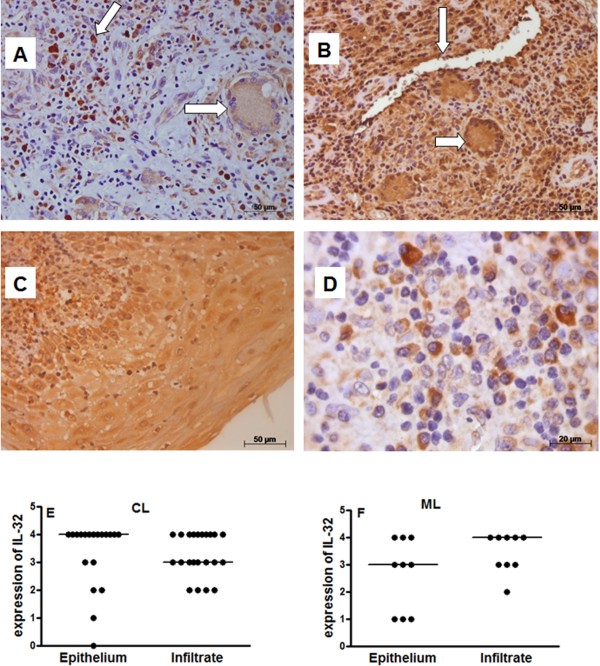
Expression of IL-32 is detected in different cells. Fragments of cutaneous or mucosal lesions were included in paraffin and sections were submitted to IHC for IL-32. The arrows show positive cells: In panel A: mononuclear cell and giant cell; and Panel B: endothelial cells and giant cell. In Panel C: positive keratinocytes; and Panel D: several positive mononuclear cells. The expression of IL-32 was determined, under light microscopy, in epithelium and infiltrate of CL (E, n = 22) and ML (F, n = 9). The data represent individual and median values.